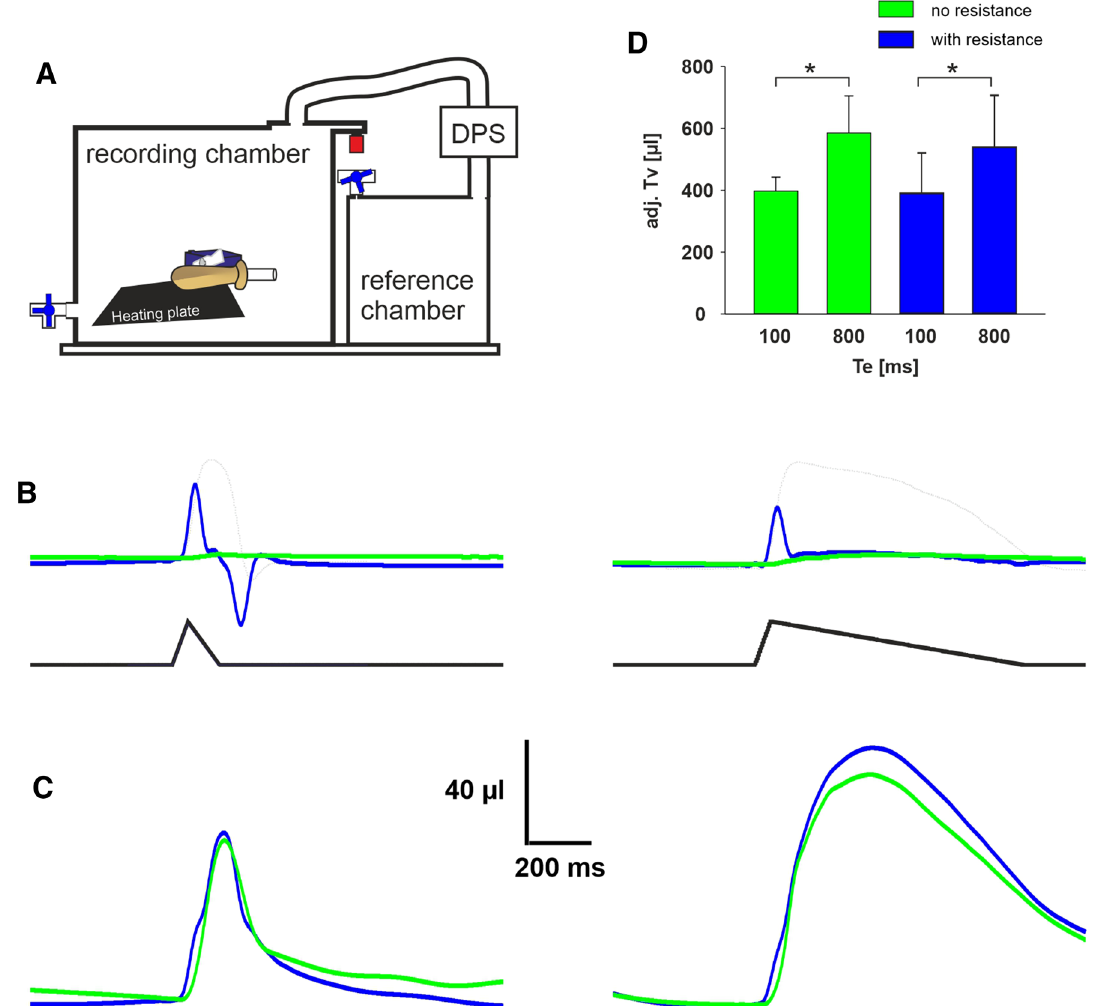
Figure 5. Measurements in the closed chamber (pressure plethysmograph (PWBP)). ( A ) Schematic drawing of the chamber. ( B ) Raw volume traces from PWBP with the heating plate off; without resistance (green trace) and with a resistance attached to the ALM (blue trace) for T E 100 ms (right) and T E 800 ms. ( C ) Raw volume from the same ALM as in ( B ) with heating turned on. ( D ) Bar chart of the basic statistical data of the adjusted volumes. DPS = differential pressure sensor. Gray traces in ( B ) represent the pressure/volume curve of the ALM shown in Fig. 1E